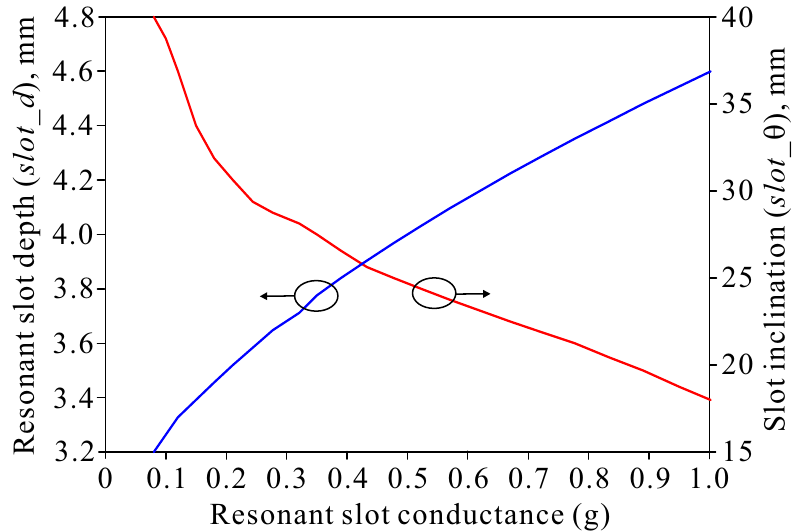
Figure 7. Parameter extraction curves of the resonant slot cutting depth and inclined angle versus the resonant slot conductance for the HP